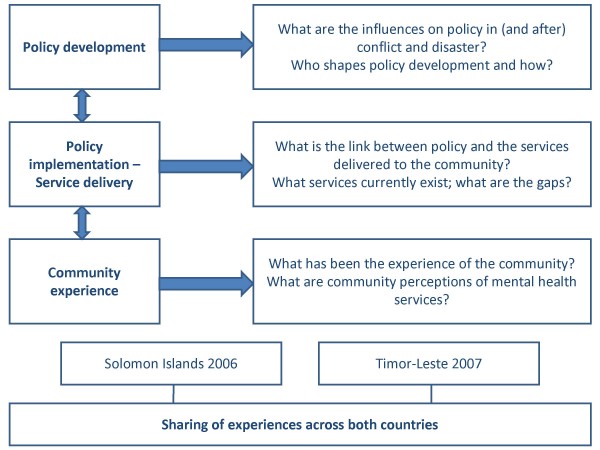
Research approach.